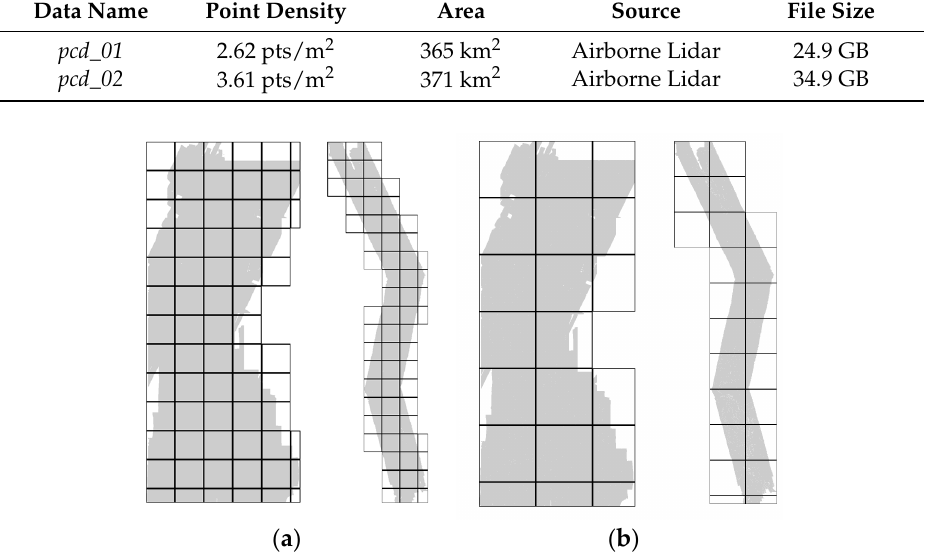
Figure 8. Grid decomposition of different LiDAR point clouds. ( a ) pcd_01 and pcd_02 on hpc_01; ( b ) pcd_01 and pcd_02 on hpc_02.